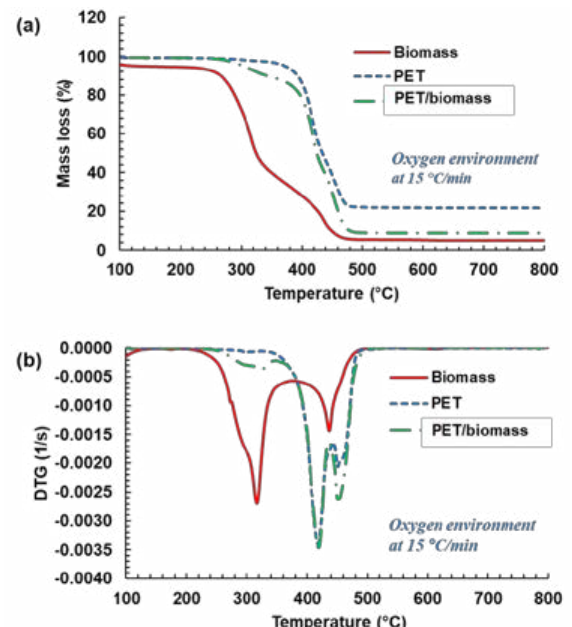
Fig. 3: (a) TGA and (b) DTG for combustion of waste of PET (PET), biomass (Biomass), and pellets (PET/biomass) at 15 °C/min